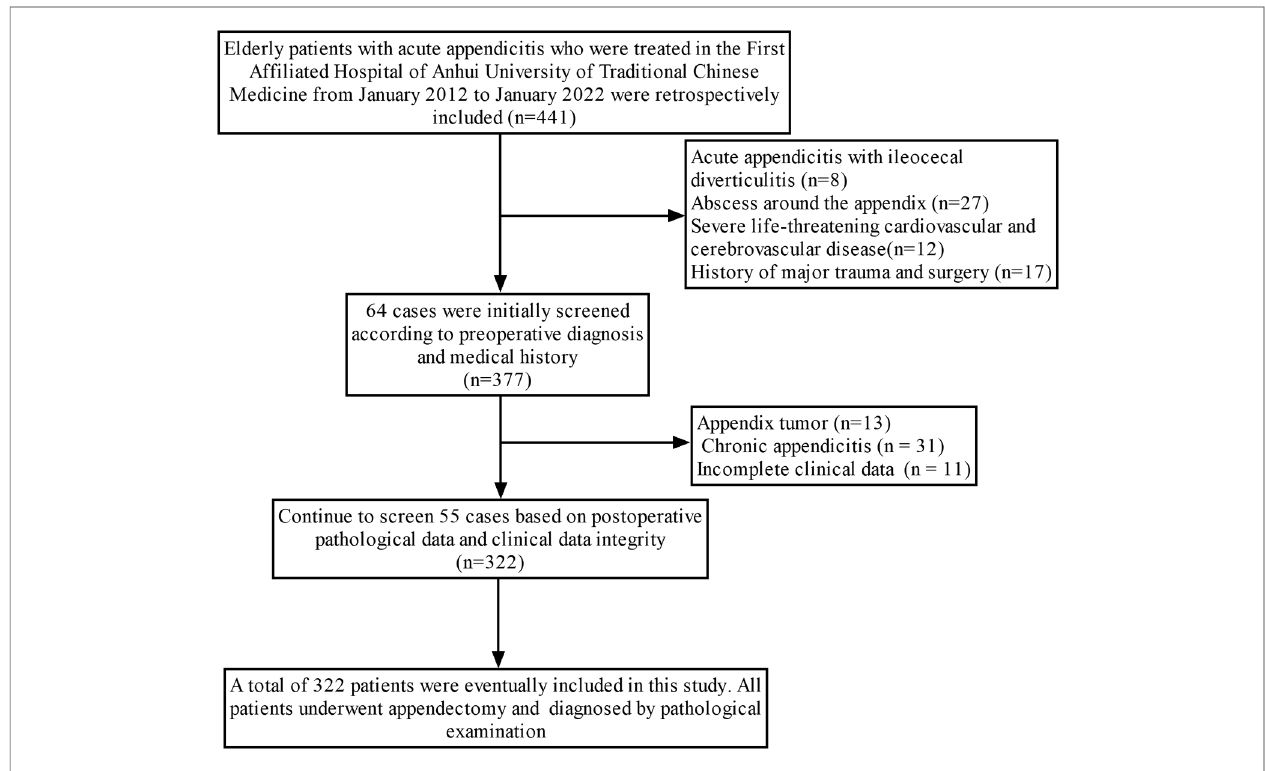
FIGURE 1 | Flow chart of patient